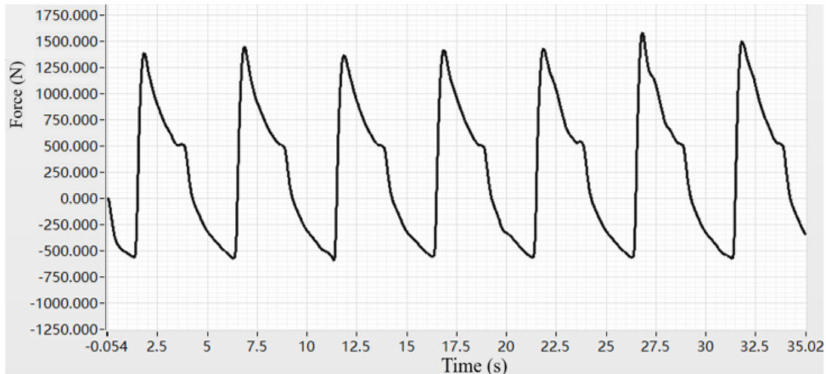
Figure 18. Lateral force waveform under step command.